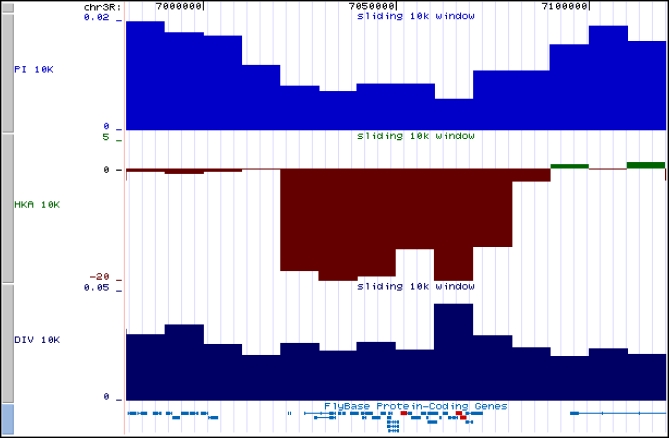
Snapshot of UCSC Browser Tracks in a Genomic Region Showing Significantly Reduced Heterozygosity Relative to DivergenceNucletotide π (blue, labeled “PI 10K”) and div on the D. simulans lineage (black), labeled “DIV 10K” in 10-kbp windows are plotted every 10 kbp. χ2[-log(p)] (green, labeled “HKA 10K”) as a measure of deviation (+ or −) in the proportion of polymorphic sites in 10-kbp windows is plotted every 10 kbp (see Materials and Methods). The genes scpr-A, scpr-B, and scpr-C exhibit high levels of expression in the testes and are indicated in red.